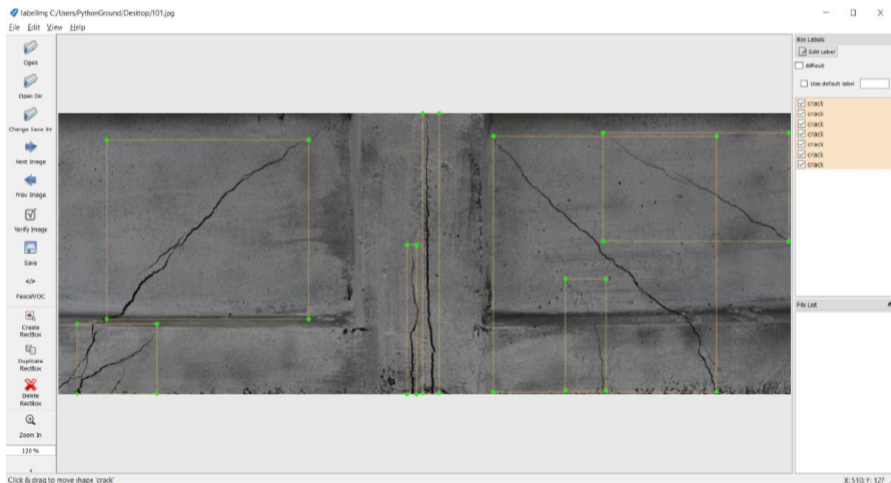
Figure 6. Example of annotation of an image of concrete element containing several cracks.